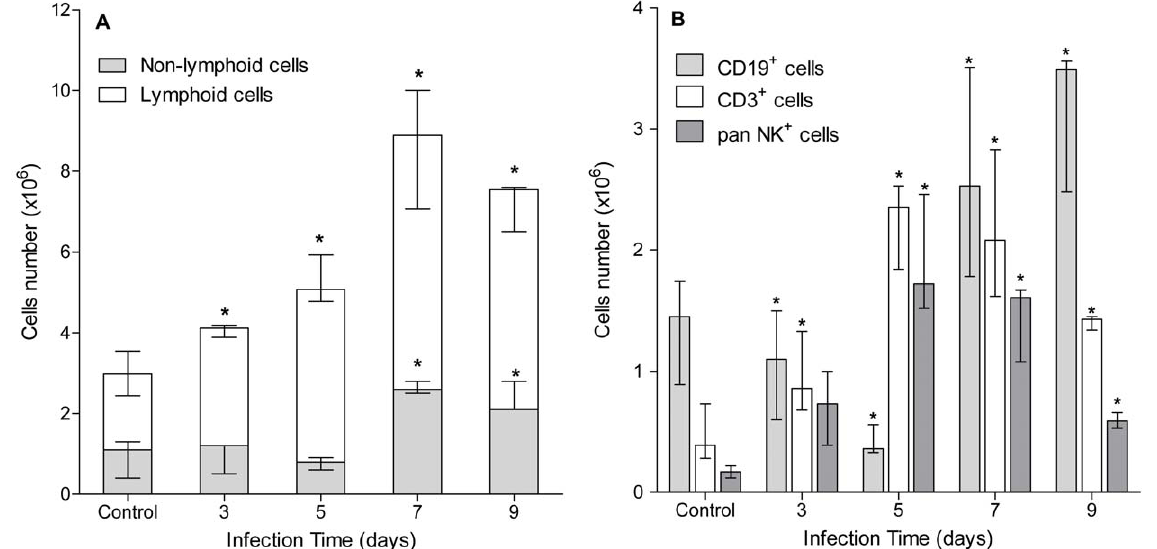
Figure 1. Peritoneal lymphocytes show disparate behaviors at very early stages of experimental infection. A group of mice (n=12) was inoculated ip with 2000 protoscoleces and another group (n=8) was inoculated with equal volume of sterile PBS (control group). Three infected and 2 control animals were sacrificed at days 3, 5, 7 and 9 pi and their total peritoneal leukocytes, lymphocytes and non-lymphoid cells (A), and T (CD3 + ), B (CD19 + ) and NK (panNK + ) lymphocytes (B) were analyzed by flow cytometry. Results are shown as group median and data range. (*) Statistical significance (p , 0.05) compared to control group. Results are representative of two independent experiments.